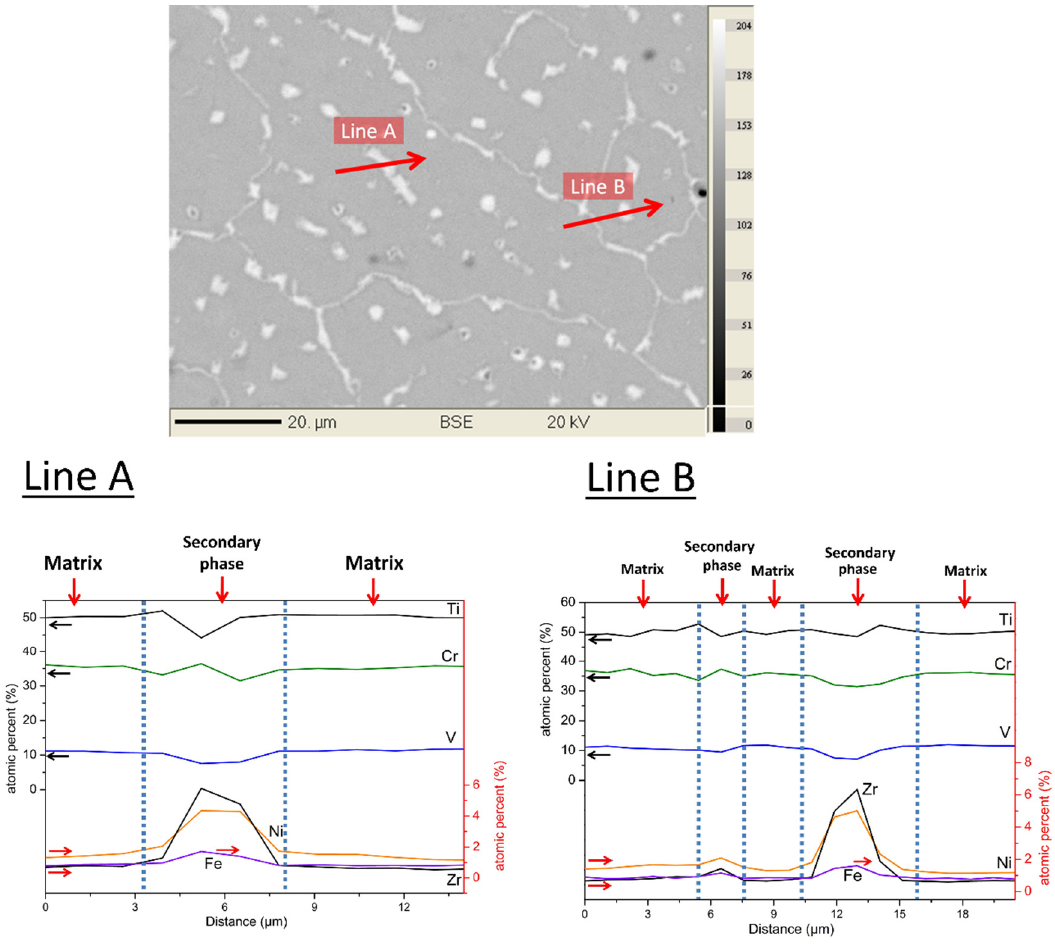
Figure 2. Linear chemical analysis of the as-cast co-melt Ti 1.56 V 0.18 (FeV) 0.18 Cr 1.08 + 4% Zr 7 Ni 10 alloy; lines positions are indicated on the backscattered electrons (BSE) SEM micrograph.